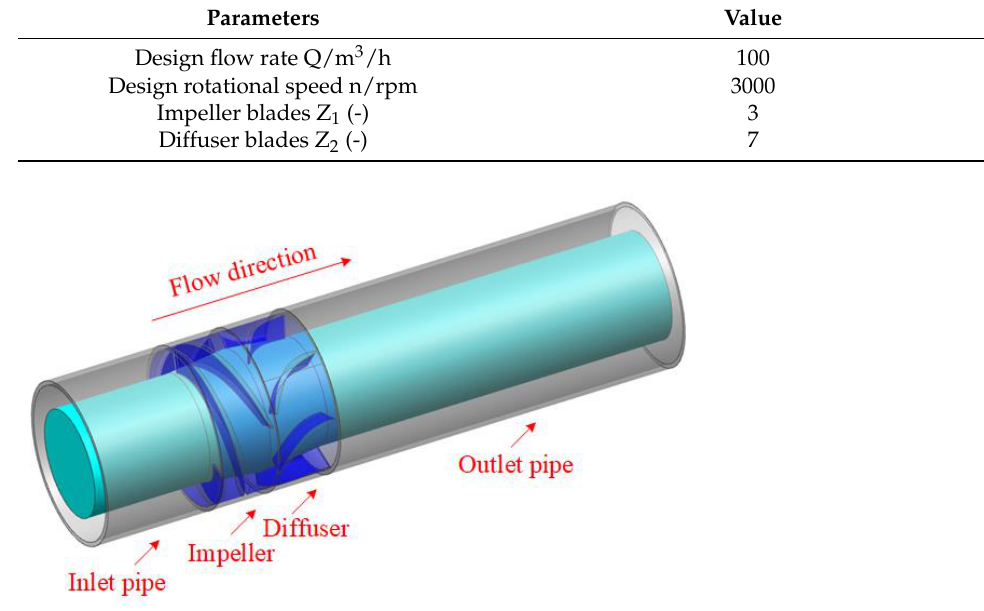
Figure 1. Computation model.